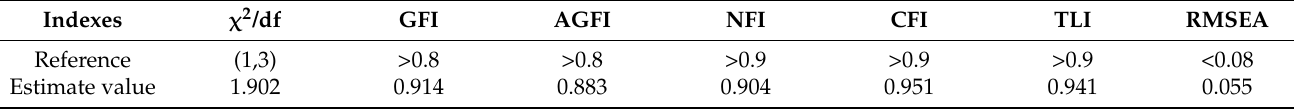
Table 6. Model-fit